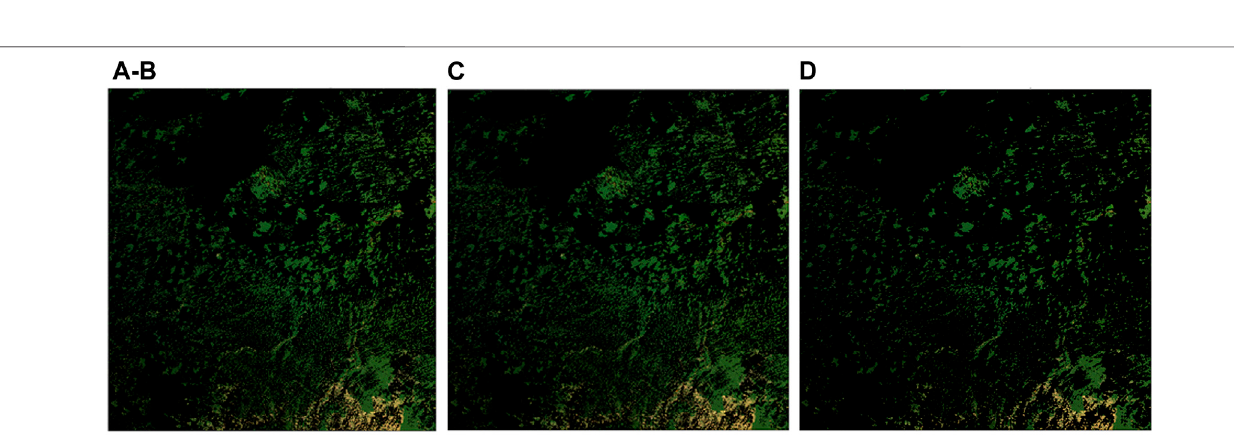
Frontiers in Remote Sensing |